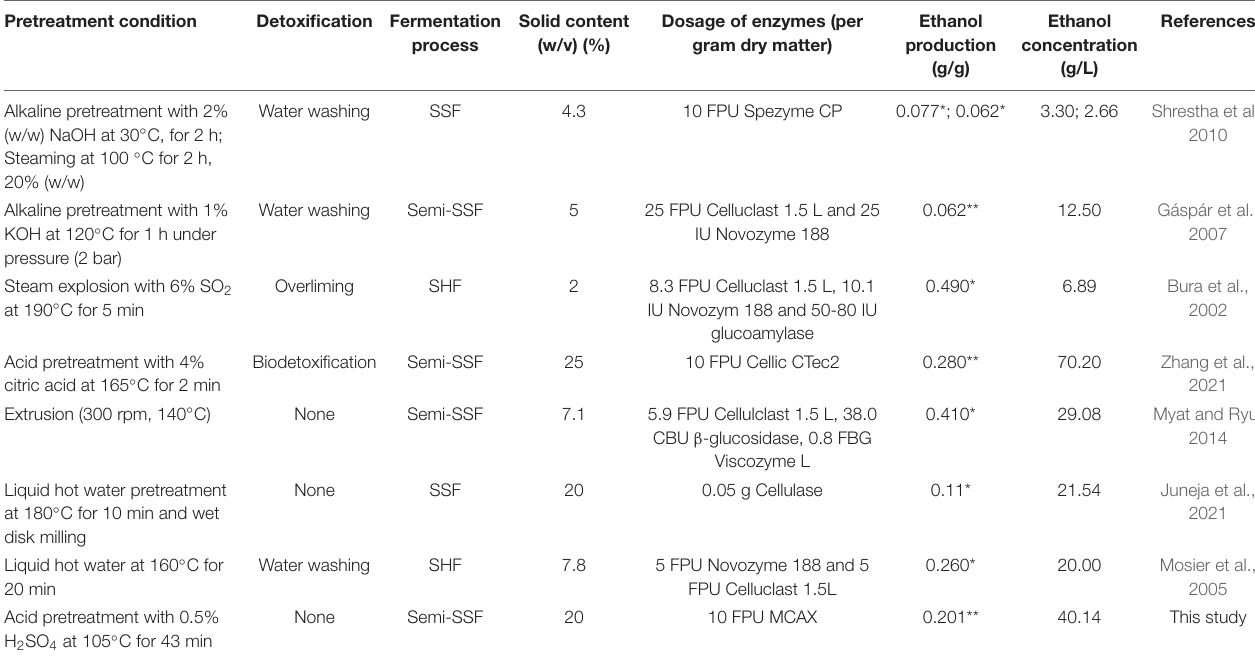
FIGURE 4 | Time courses of sugar utilization and ethanol production during semi-SSF with S. cerevisiae LF2 and corn fiber pretreated at 105 ◦ C; 0.5% H 2 SO 4 for 43 min; fermentation conditions: 20% (w/v) of solid content, 30 ◦ C and pH 5.0. TABLE 4 | Comparison of cellulosic ethanol production from corn fiber